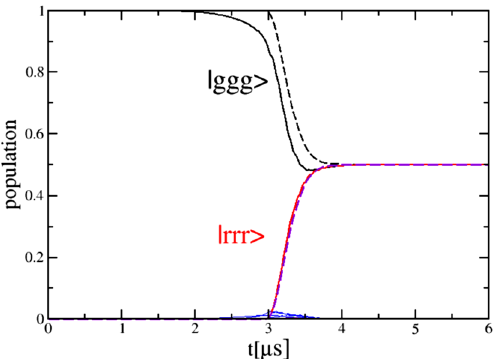
ggg rrr and states leading to the formation of the | � | � 1.5 GHz, δ 100 MHz, 1 µ s, (cid:31) = − = − = 150 MHz . Dashed curves show an approximate solution =